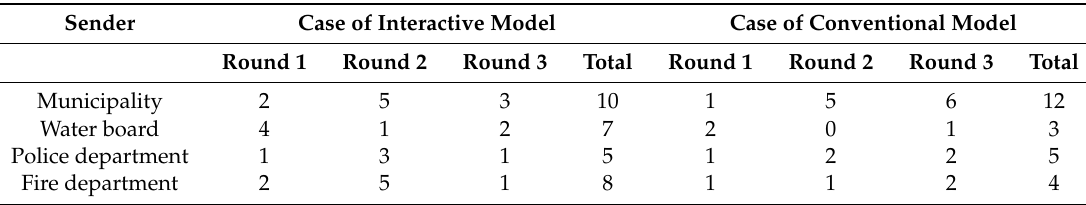
Table 6. Involvement of di ff erent stakeholders in the formulation of follow-up actions after each round with and without the use of an interactive model, monitored by the number of statements per